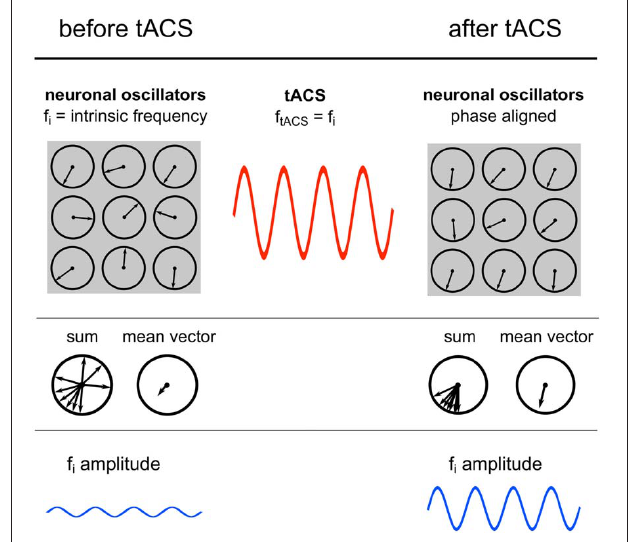
FIGURE 7 | Power increase by synchronization. Illustration of the proposed underlying neuronal mechanism of the power effect. Upper row: Single neuronal oscillators, depicted as vectors on a unit circle, with a specific intrinsic frequency synchronize to an external sinusoidal force with the same frequency. Middle row: The mean resultant vector of the single oscillating elements represents the amplitude of the oscillation. Due to phase alignment of each single oscillator to the external oscillation, the length of this mean vector increases and likewise the amplitude. Lower row: Schematic illustration of the amplitude recorded via